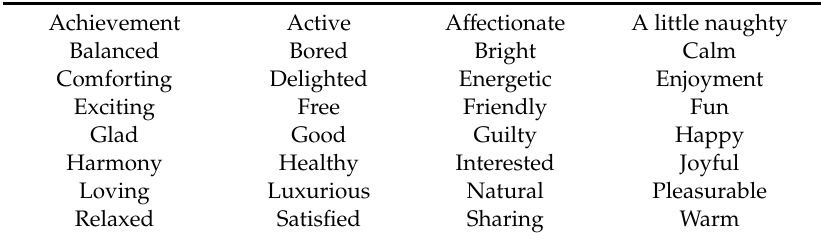
Table 3. Lexicon of emotions for chocolate given for the Check-All-That-Apply (CATA) question. Achievement Active A ff ectionate A little naughty Balanced Bored Bright Calm Comforting Delighted Energetic Enjoyment Exciting Free Friendly Fun Glad Good Guilty Happy Harmony Healthy Interested Joyful Loving Luxurious Natural Pleasurable Relaxed Satisfied Sharing